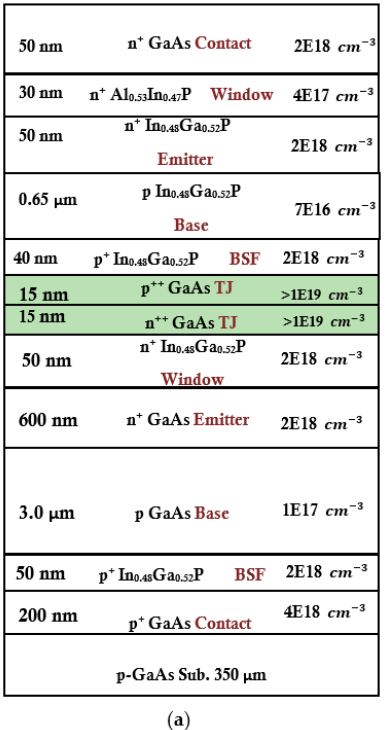
the minority carrier (electron), reducing rear surface recombination. As a window layer with a higher bandgap than the base layer, n + -Al 0.53 In 0.47 P and n + - In 0.48 Ga 0.52 P layers are introduced in the top and bottom cells to suppress the front surface recombination, respectively. A highly doped GaAs tunnel junction is embedded between the top and bottom cells to electrically and optically interconnect them [9].